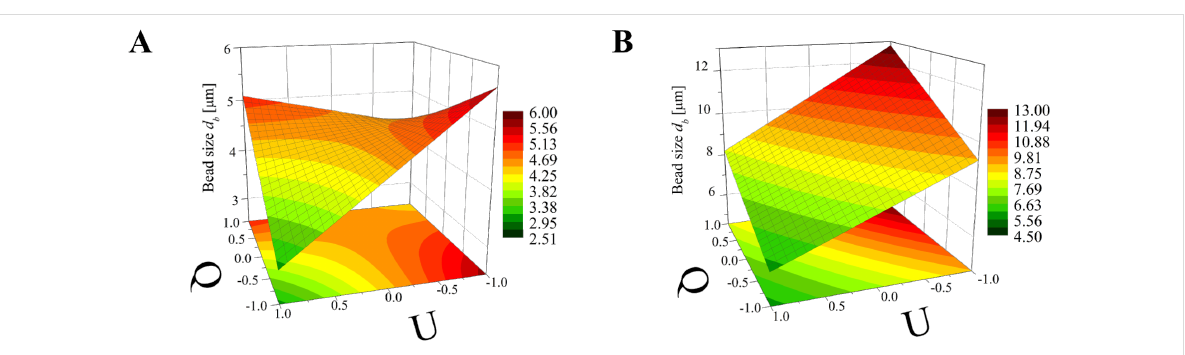
viscosity has the largest impact on fiber size and causes a change of around 700 nm when its value increases from the low level (µ = − 1) to the high level (µ = 1) . In this case, the elec- trical voltage impact is about tenfold